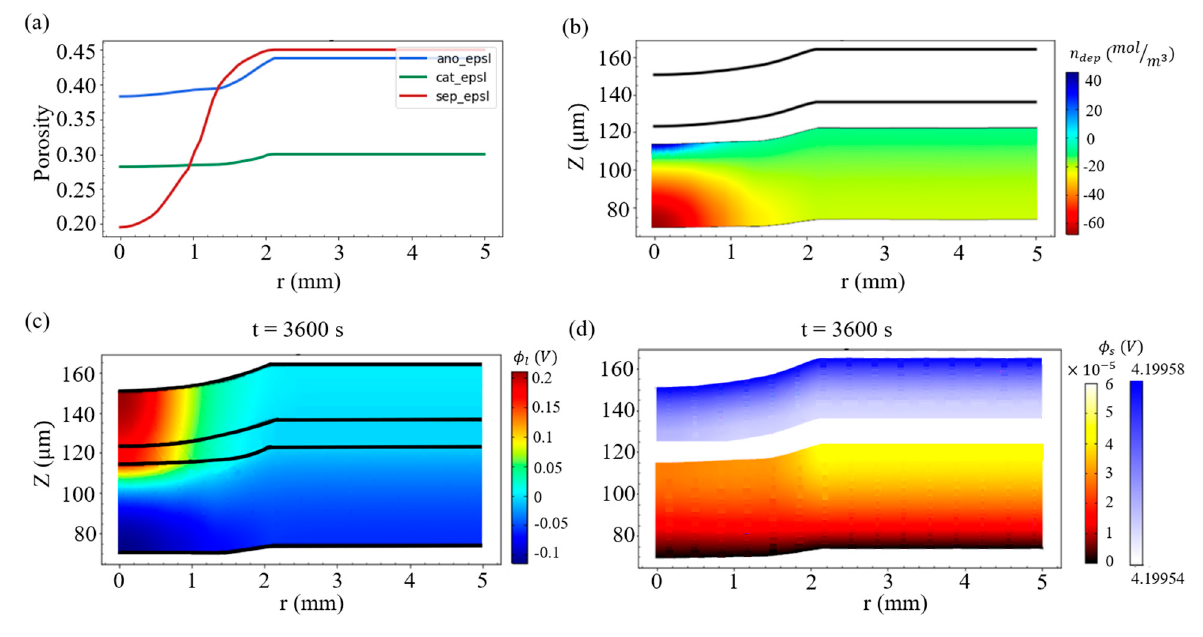
Figure 5. ( a ) Distribution of the volume fractions of the electrolyte (porosity) in the anode, cathode, and separator under the strain of 8%. ( b ) Field of Li metal production in the negative electrode, ( c ) field of the electrolyte potential, and ( d ) potential field of the solid electrode at the end of charging.